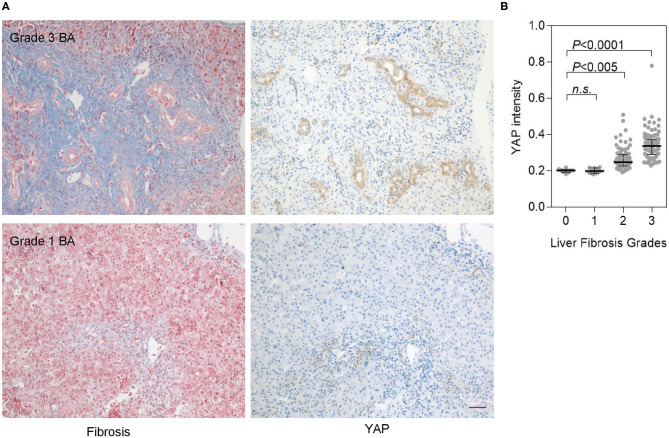
YAP expression is positively correlated with fibrosis in BA livers. (A) Fibrosis (Masson's trichrome staining) and YAP expression (IHC) in consecutive sections of BA livers. Scale bar: 100 μm. (B) Correlation between YAP expression and liver fibrosis revealed by the Spearman's rank correlation analysis. Significantly higher YAP expression was observed in Fibrosis Grade 3 and 4 BA livers.